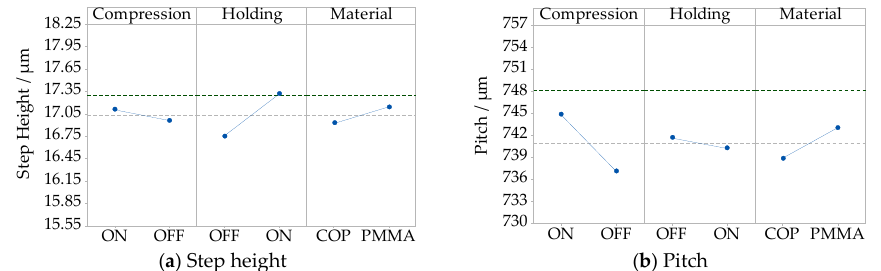
Figure 8. Main effects plot of compression, holding, and material on the average replication of the absolute dimensions of a Fresnel lens’ groove with a nominal height of 17.3 µm and width 748.1 µm: ( a ) effects on step height; ( b ) effects on pitch.